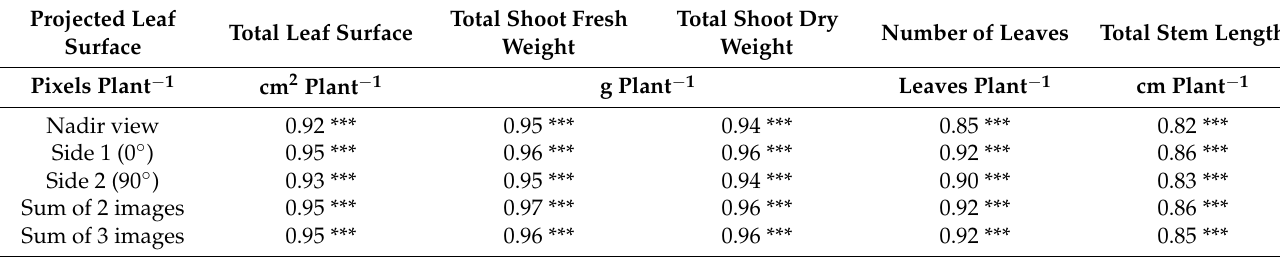
Table 1. Pearson’s correlation coefficients between projected leaf area measured with the nadir view, side view 1 (0 ◦ ) and 2 (90 ◦ ), the sum of two views (nadir and side view 1) and the sum of three views and total leaf area, total fresh and dry weight, number of leaves and total stem length of water yam cv raja ala grown in a greenhouse during 20, 40 and 61 days after emergence in the presence of different N fertilization rates. *** Denotes significance responses on p -values 0.001 ( n = 60 plants for each